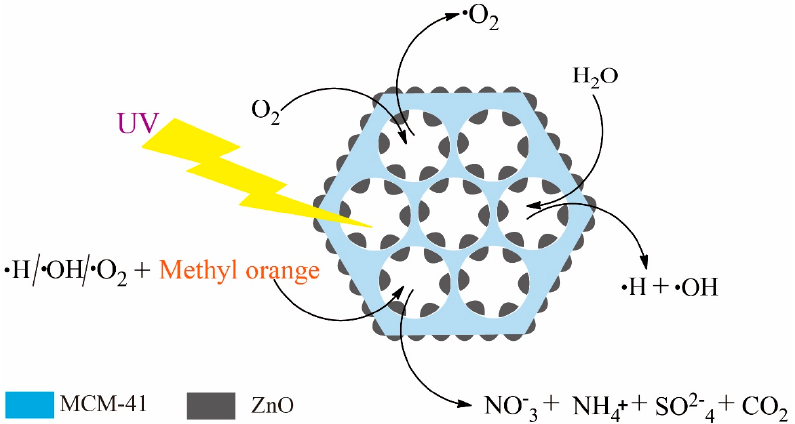
Scheme 2. Schematic illustration of degradation mechanism.